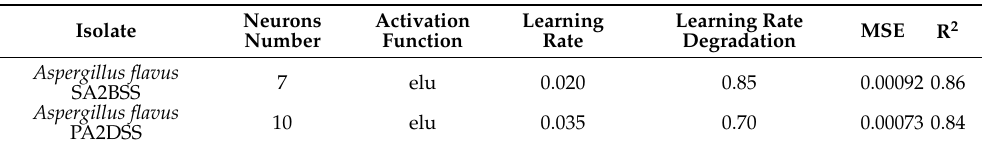
Table 11. Hyperparameters and results of model training using ANN methodology, with MSE and R 2 calculated on the validation